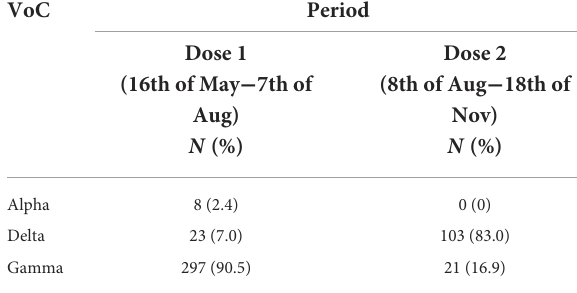
TABLE 2 VoC distribution by time